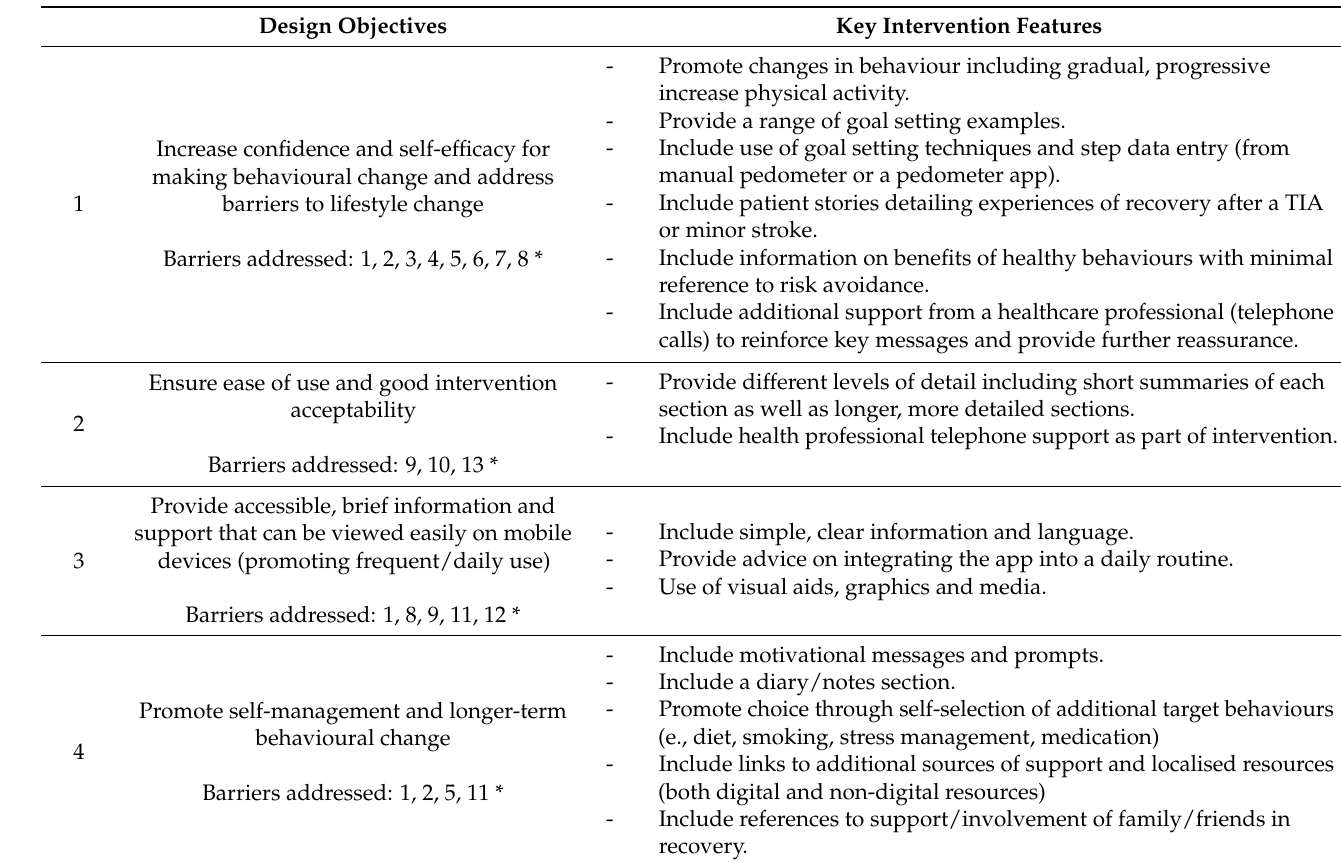
Table 4. Intervention guiding principles showing design objectives and key intervention features. Design